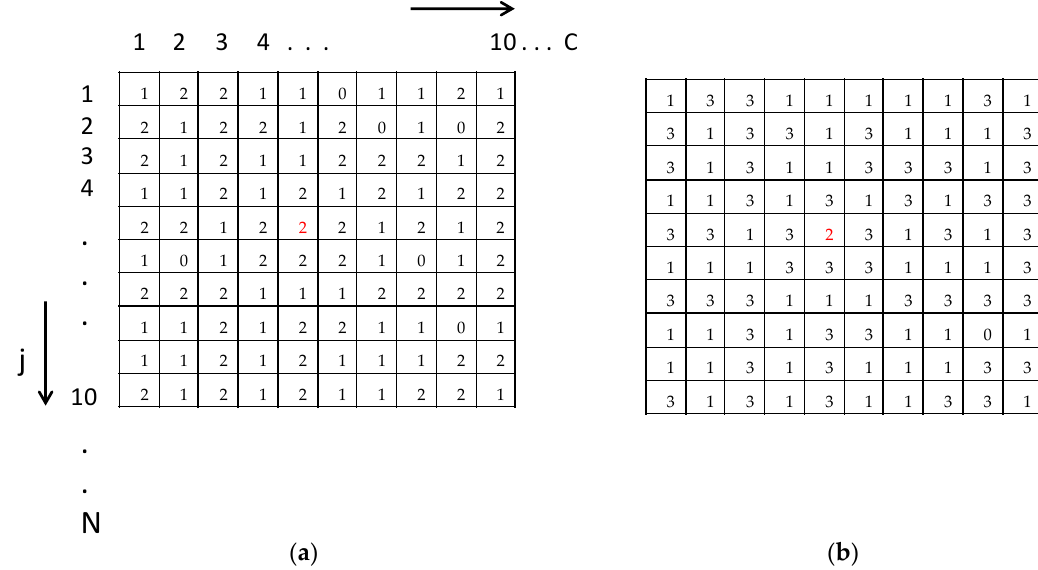
= 5% for: ( a ) initial time 2